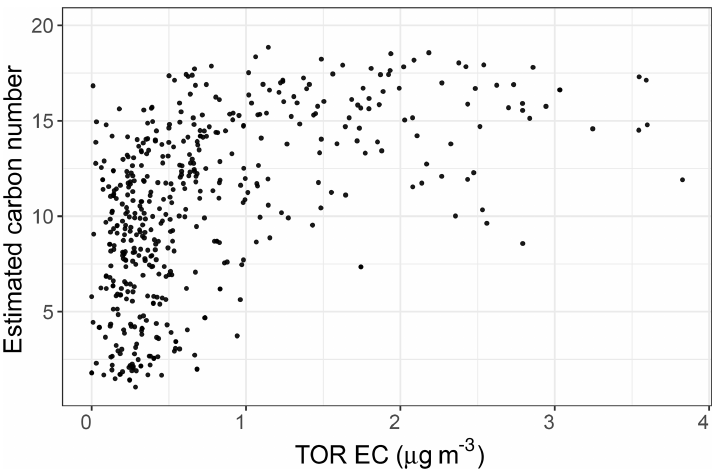
Figure C1. Scatter plot showing the relationship between collocated measurements of EC concentration and carbon number estimates by PLSR models in the IMPROVE network in 2011 and